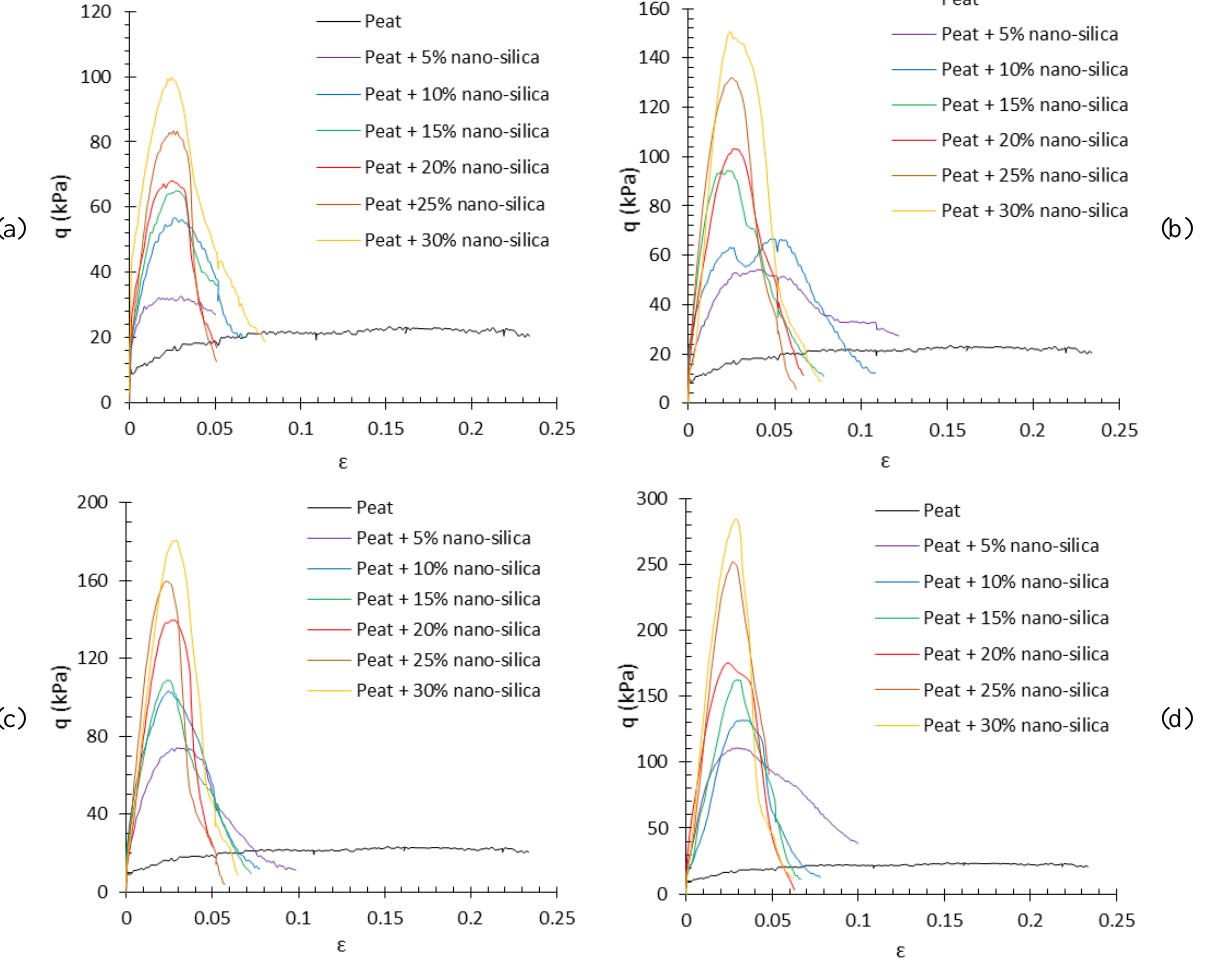
Figure 3. Stress-strain response of optimum compacted natural peat and modified peats with nano-silica colloidal solutions, with curing times (a) 1 day, (b) 7 days, (c) 14 days, (d) 28